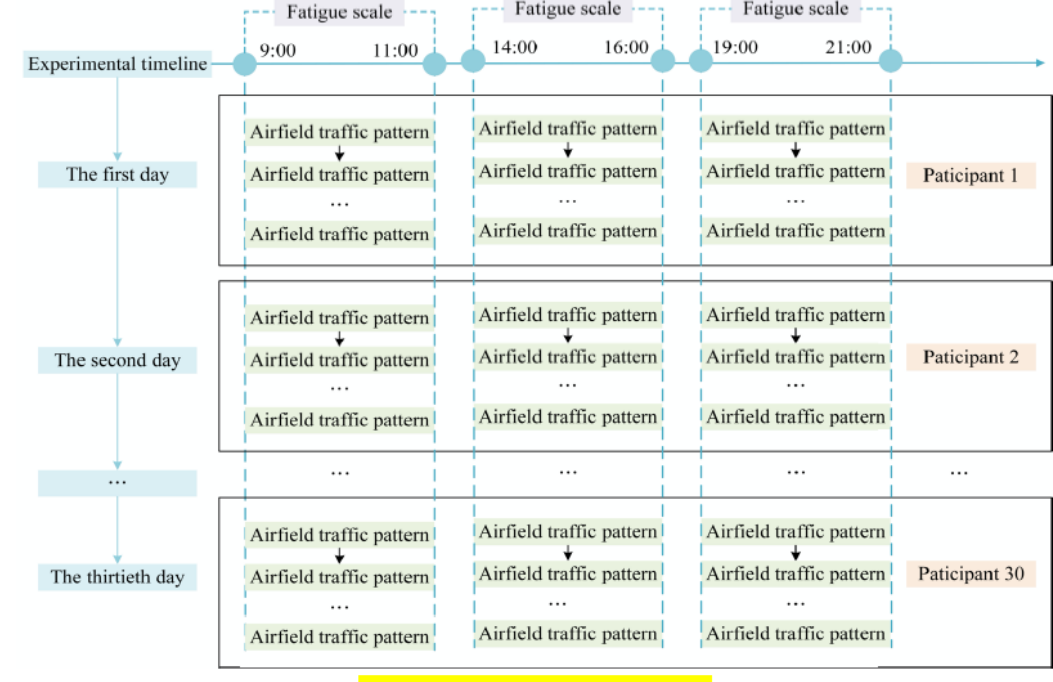
Figure 8. Experimental process.